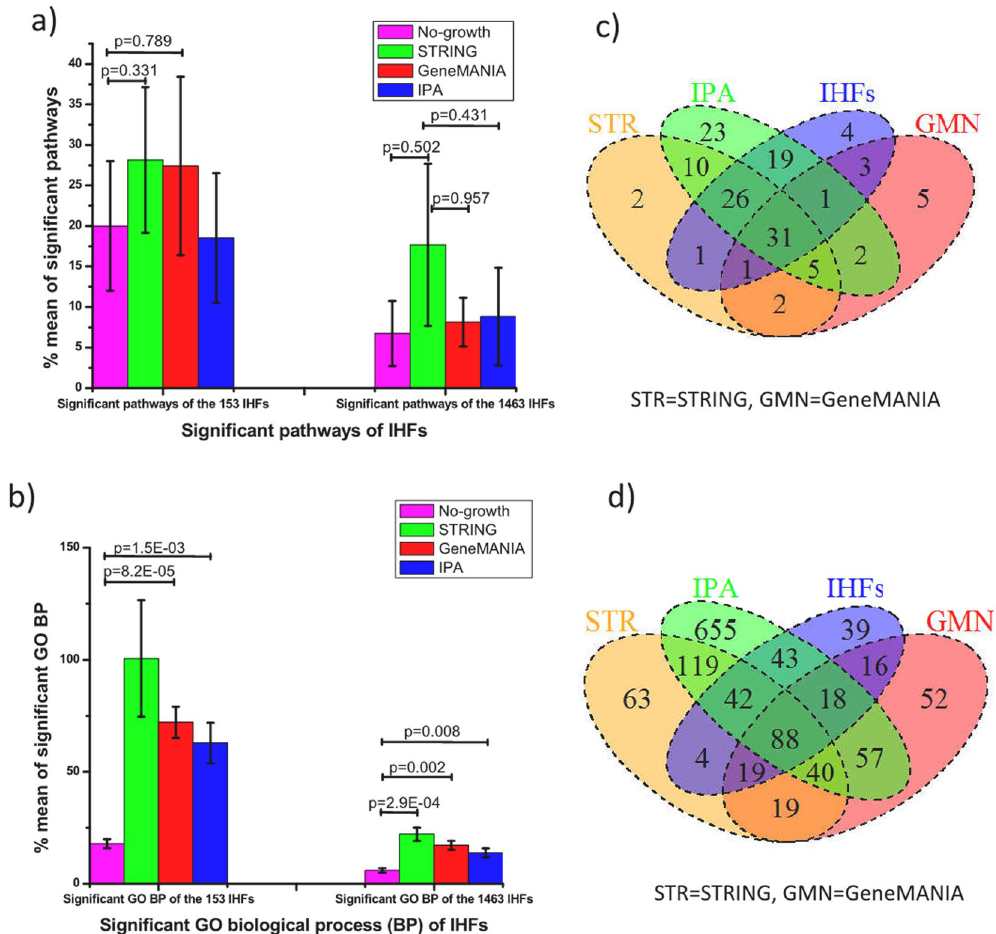
Figure 3. Performance comparison of the three network growing tools in terms of KEGG pathways and GO BP. ( a ) Rate of overlapping KEGG pathways before and after network growing relative to pathways of the 153 and 1463 known IHFs. ( b ) Rate of overlapping GO BP of the grown genes relative to GO BP of the 153 and 1463 known IHFs. ( c ) Pairwise analysis of KEGG pathways from the grown genes in the network growing tools and KEGG pathways of the positive sets (1463 IHFs) ( d ) Pairwise analysis of GO BP from the grown genes in the network growing tools and GO BP of the positive sets (1463